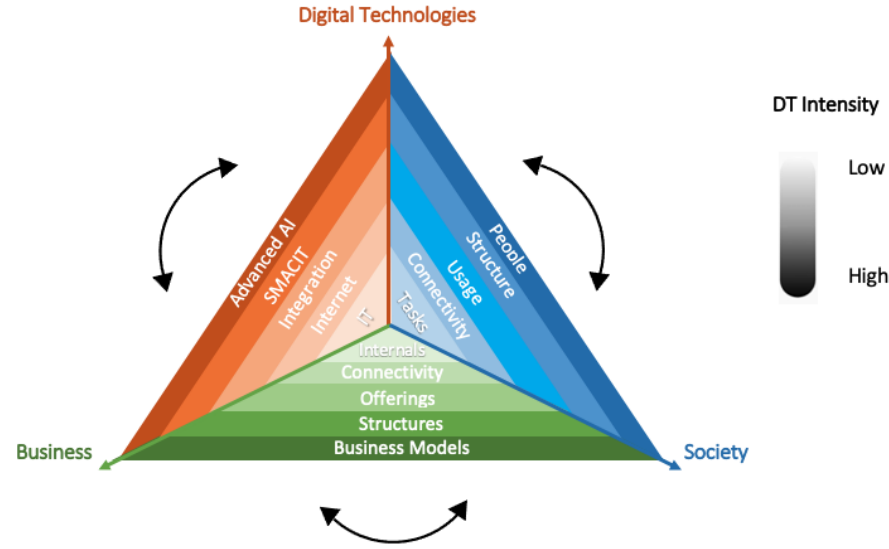
Figure 3. The digital transformation process (adapted from